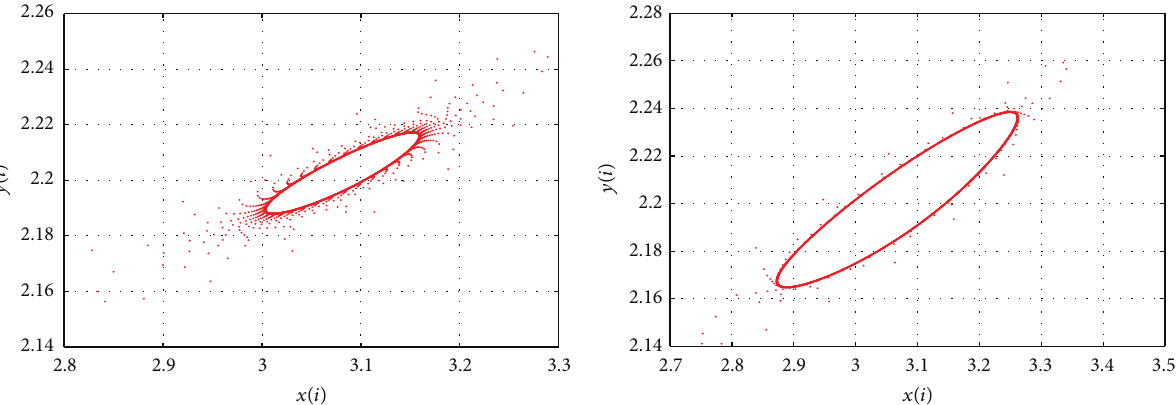
Figure 8: The portraits for several values of 𝐴 1 = 0.18 , 𝛿 = 5.34 , and 𝛿 = 5.37 .